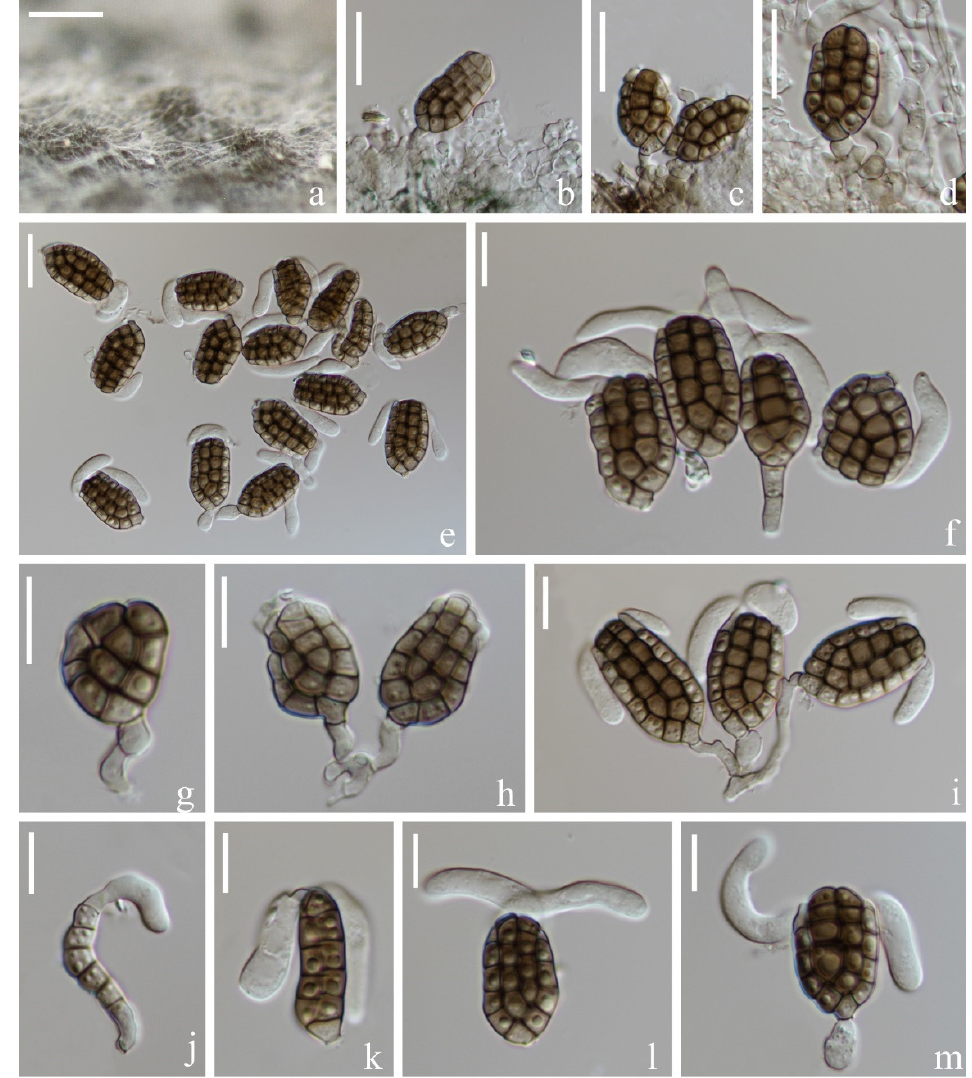
Figure 8. Dictyosprium tubulatum (KUN-HKAS 115789, new geographical record). ( a ) Colonies on the substratum. ( b – d ) Conidiophores and conidia. ( e ) Conidia heap. ( f , i , m ) Conidiogenous cells, conidia and appendages. ( g , h ) Conidiogenous cells with conidia. ( j – l ) Conidia with appendages. Scale bars: ( a ) 200 μ m, ( b – e ) 20 μ m and ( f – m ) 10 μ m.